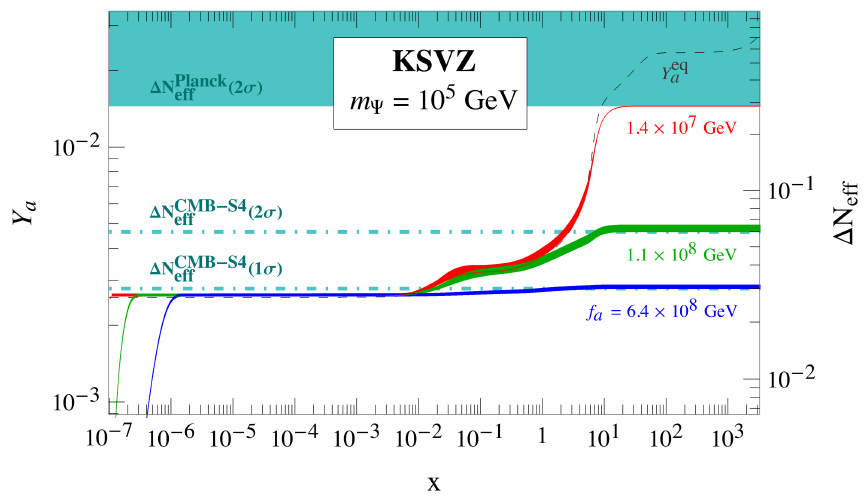
Figure 8 . Axion comoving number density Y a as a function of x = GeV /T for the KSVZ axion. The three colors for the solid lines correspond to different axion decay constants f is presented as a band whose width corresponds to two different treatments of the thermal bath relativistic degrees of freedom. The dashed black line describes the equilibrium distribution. The vertical axis on the right identifies the contribution to ∆ N